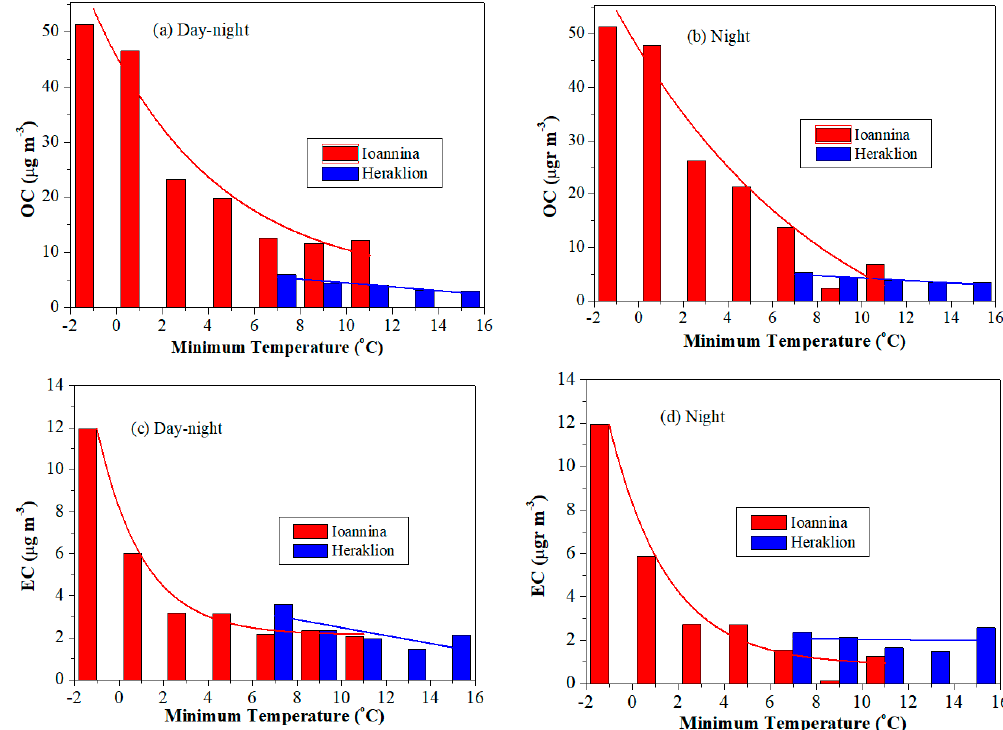
Figure 3. OC and EC concentrations averaged for T min bins in Ioannina and Heraklion for all and night-time only samples during the common measurement period. ( a ) OC day-night; ( b ) OC night; ( c ) EC day-night; ( d ) EC night.